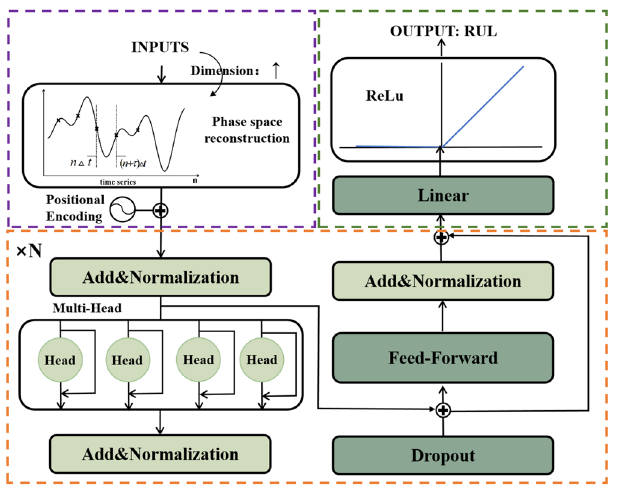
Figure 2. PSR-former model